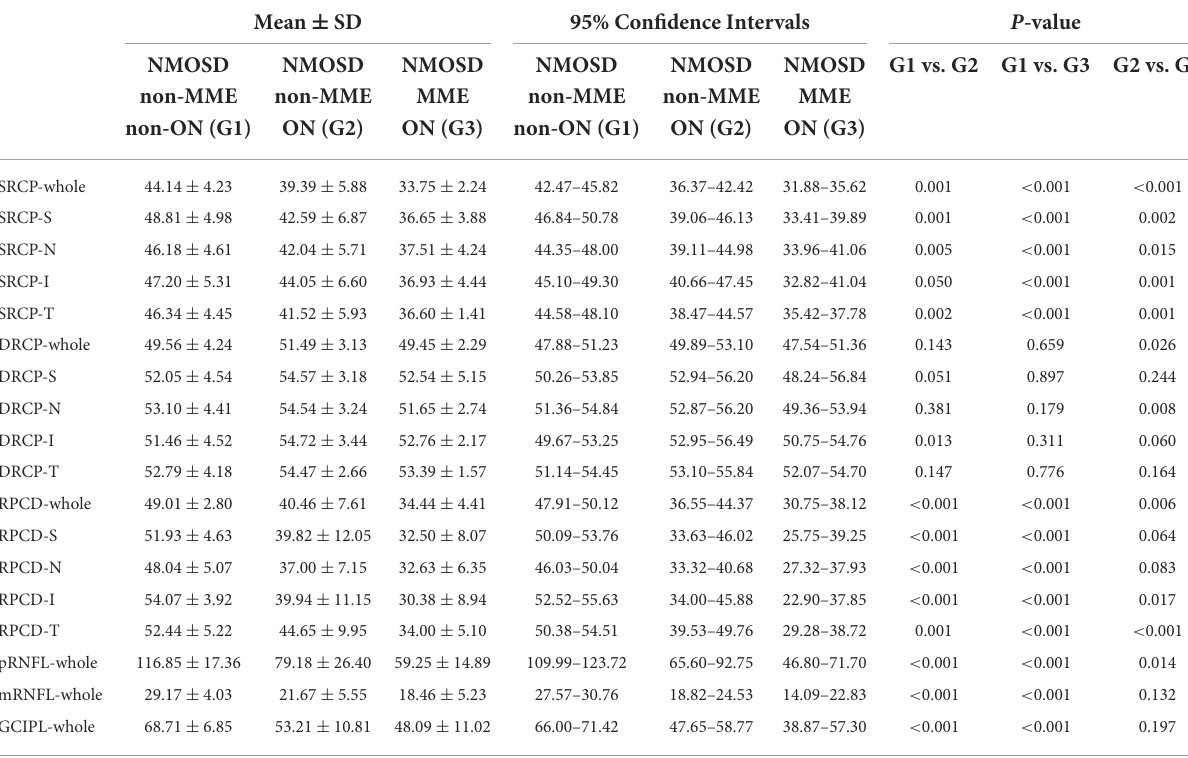
TABLE 2 Comparison of OCT and OCTA parameters among the NMOSD non-MME non-ON, non-MME ON, and MME ON groups.